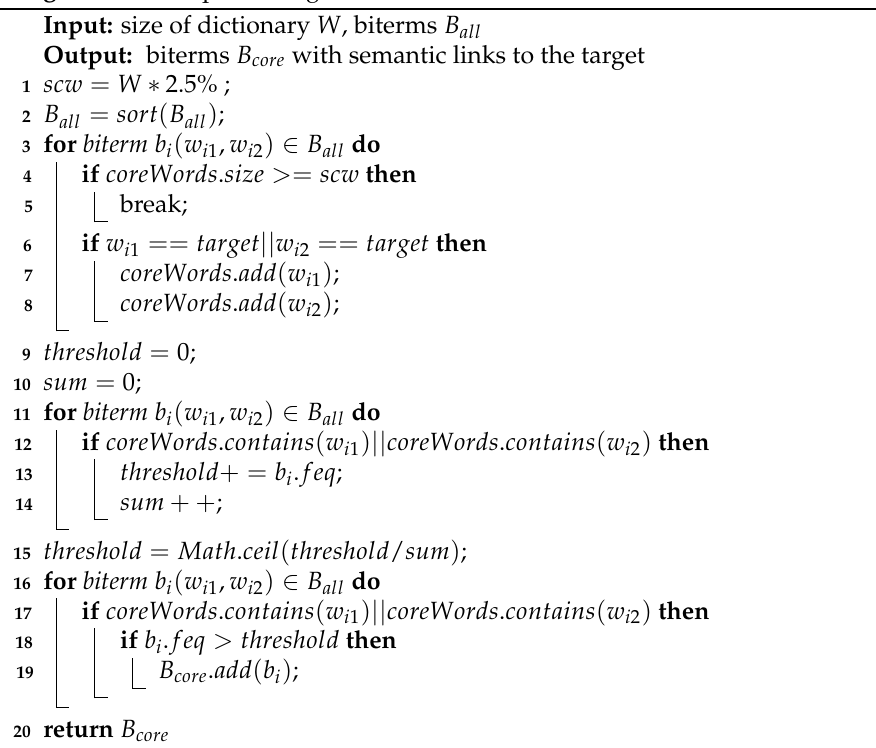
Algorithm 1: Preprocessing based on